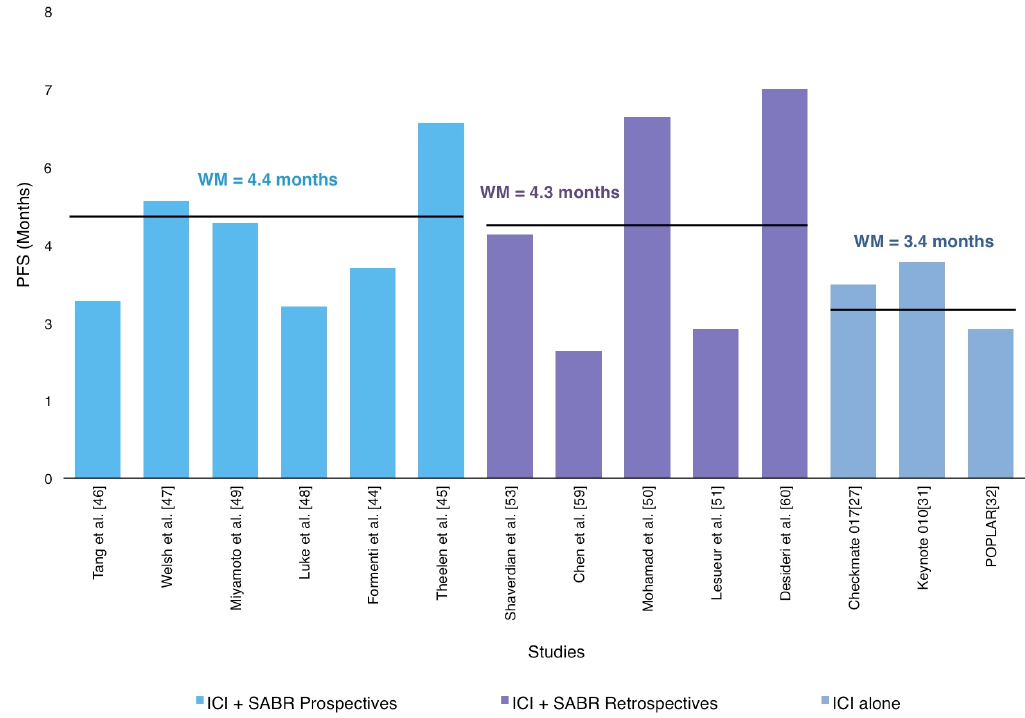
Figure 3. Distribution of weighted mean progression-free survival (PFS) according in prospective and retrospective studies in SABR-ICI combination.